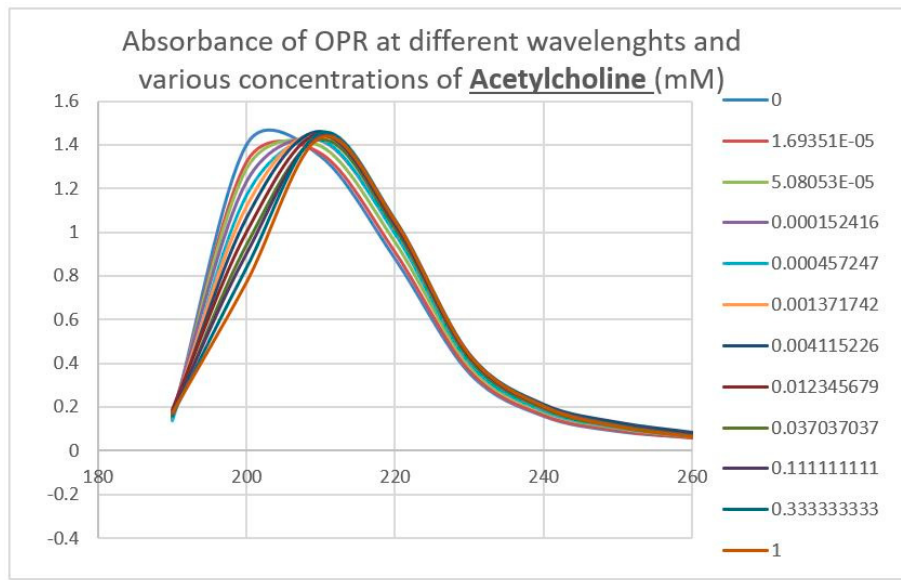
Figure 7. Effect of serial additions of acetylcholine at increasing concentrations on the UV spectrum of intact mu opioid receptors (muOPRs). The spectral shifts are due to the dilution of the receptor and do not differ significantly from those observed with equivalent additions of buffer without acetylcholine. Compare with Figures 8–10.